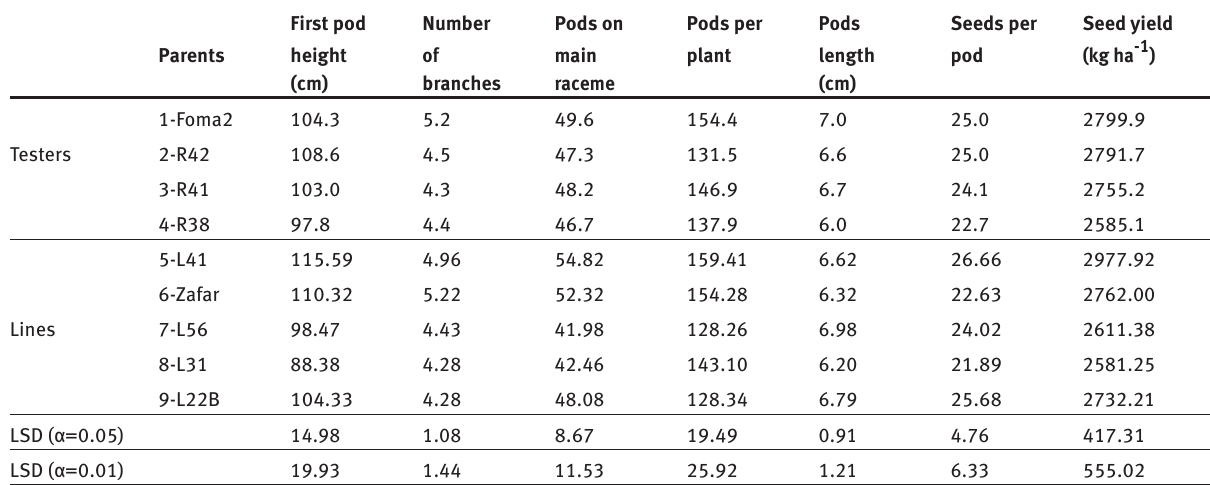
Table 2: Means of parents for yield components, seed